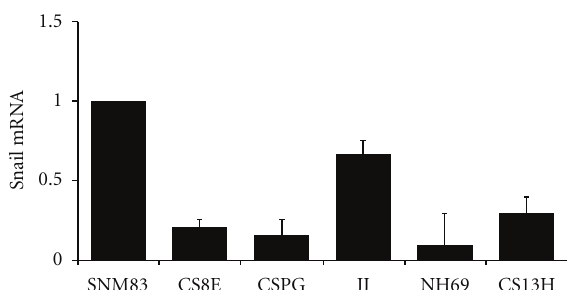
Figure 7: Snail mRNA expression is downregulated in human chondrosarcomas. All five chondrosarcoma cell lines showed a significant decrease ranging from 1.5- to a 10-fold decrease in snail mRNA expression when compared to the normal SNM83 chondrocyte cell line as determined by real-time PCR using ΔΔ CT relative quantification method. Expression is normalized to SNM83 chondrocyte